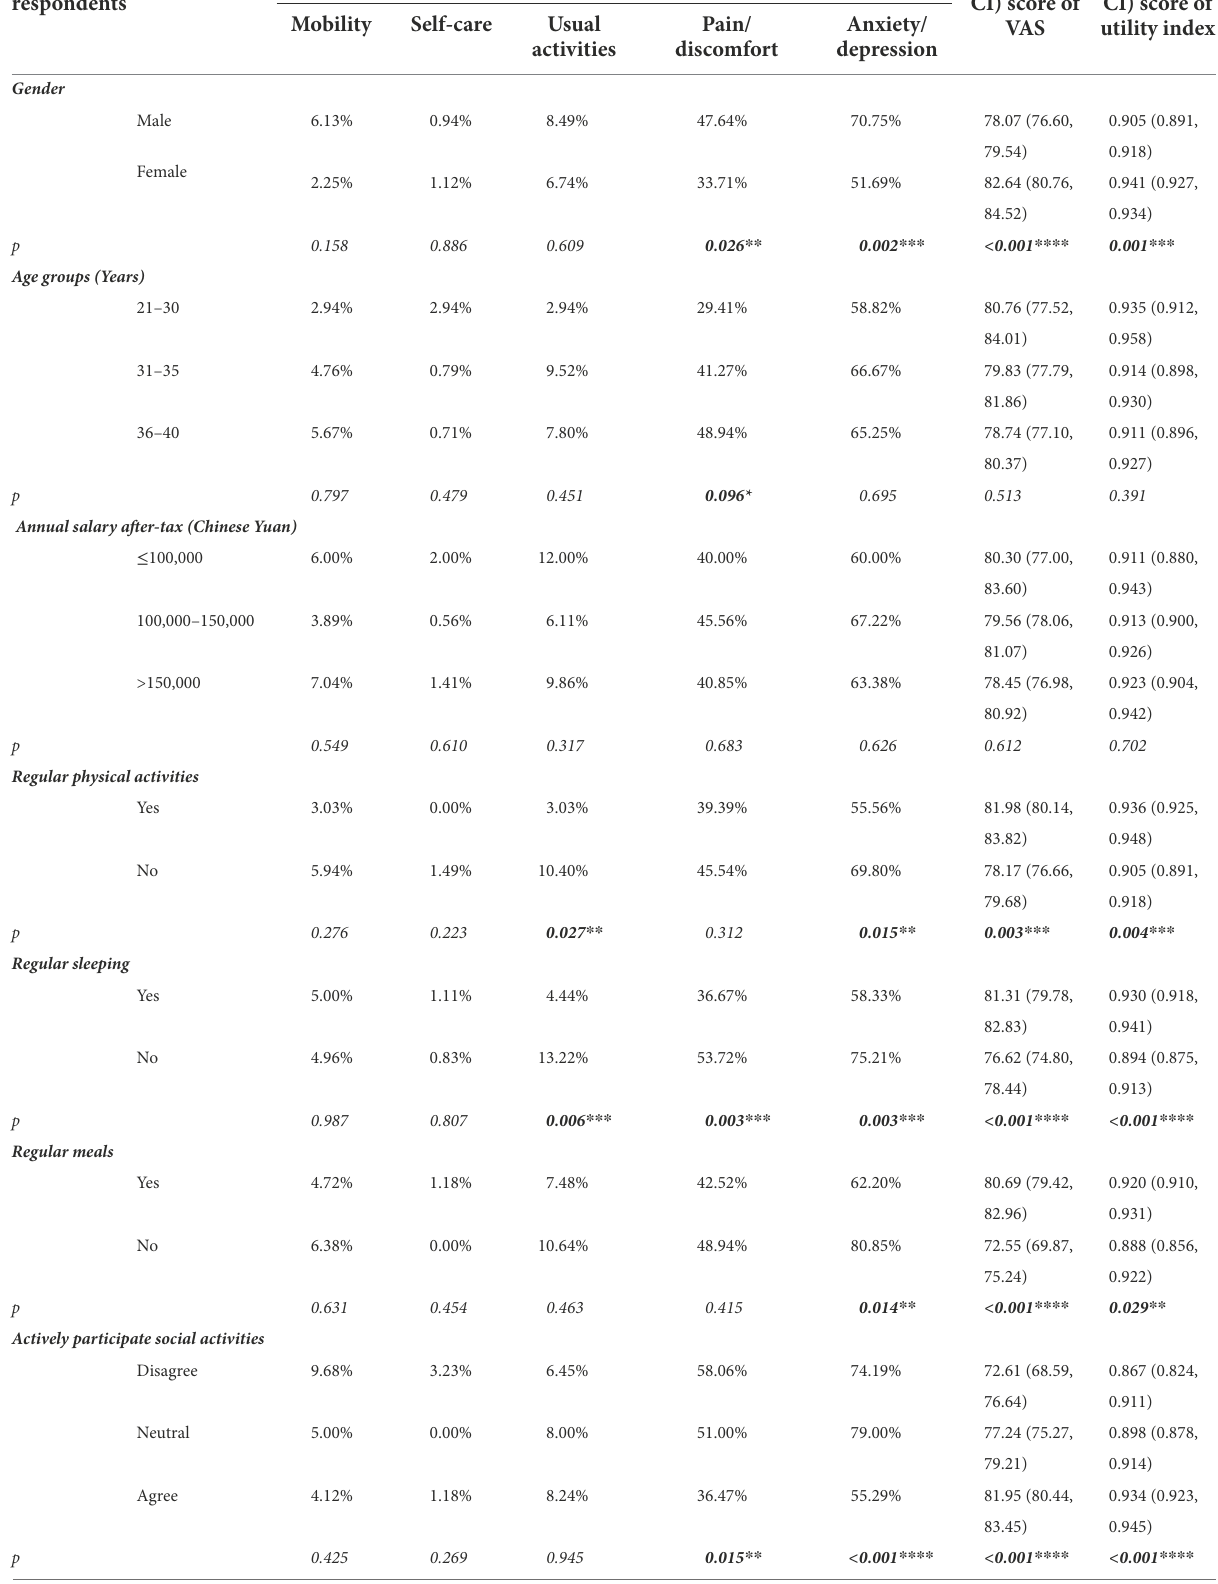
Percentage (%) of respondents reporting problems Mean (95%